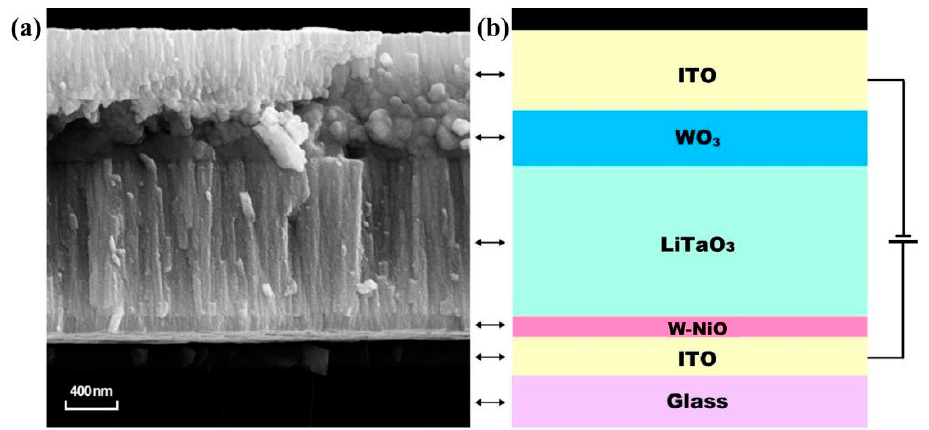
Figure 5. Cross-sectional SEM image ( a ) and schematic diagram ( b ) of the